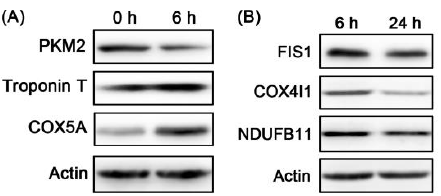
Figure 3. ( A ) Protein-protein interaction networks of differentially expressed proteins of 6 h vs. 0 h